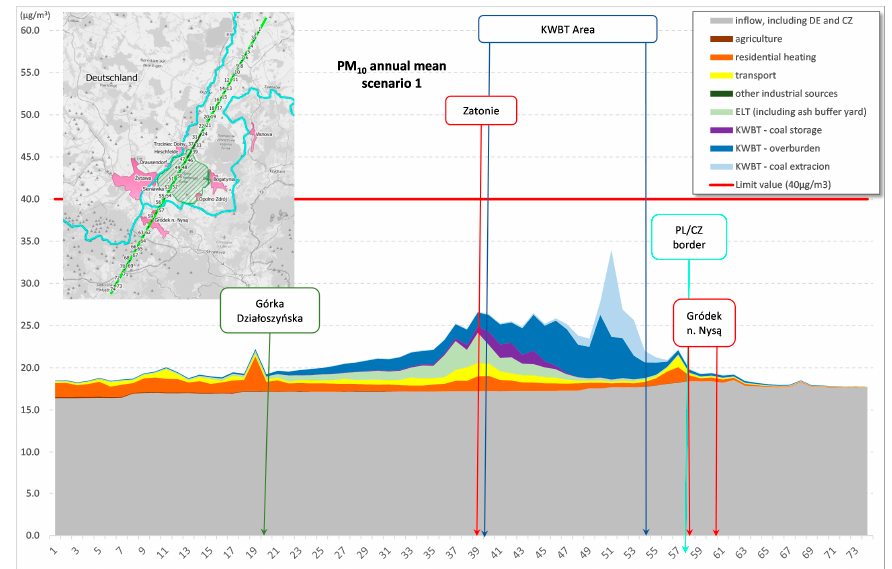
Figure 18. Profile of annual mean concentrations of PM 10 between Dzia ł oszyn and Hrádek nad Nisou, considering the shares of individual source groups for scenario 1 (source: own study).